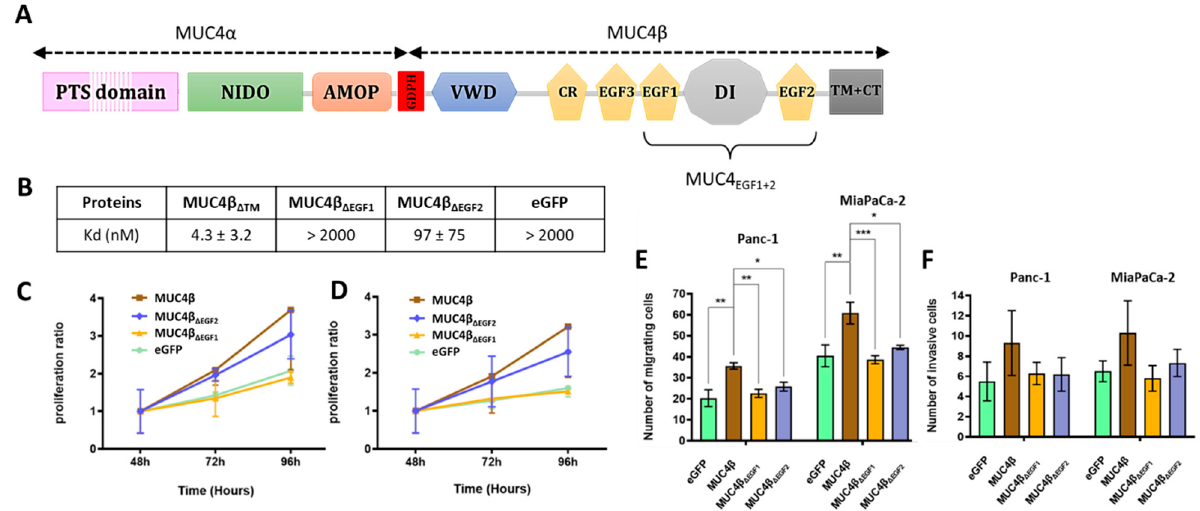
Figure 1. Impact of deletion of MUC4 EGF1 and MUC4 EGF2 domains on binding affinities with HER2 and on proliferation and migration properties of human PC cells. ( A ) Schematic representation of the membrane ‐ bound mucin MUC4 featuring both subunits MUC4 α and MUC4 β . MUC4 α is rich in proline/serine/threonine residues (PST domain), is strongly O ‐ glycosylated, and contains the AMOP and the NIDO domains. The subunits are post ‐ transcriptionally cleaved by an auto ‐ cleavable GDPH sequence and noncovalently associated. MUC4 β is formed by a von Willebrand factor ‐ D (VWD), an uncharacterized strongly N ‐ glycosylated part, a cysteine ‐ rich domain (CR), two EGF ‐ like domains (EGF3 and EGF1), an intermediate uncharacterized domain (DI), another EGF ‐ like domain (EGF2), and a transmembrane helix (TM) with a short cytoplasmic tail (CT). ( B ) Measurement of binding affinities between HER2 and eGFP ‐ MUC4 β Δ TM containing the EGF domains (MUC4 β Δ TM ) and the deleted forms for each EGF domain: eGFP ‐ MUC4 β Δ EGF1 (MUC4 Δ EGF1 ), eGFP ‐ MUC4 β Δ EGF2 (MUC4 Δ EGF2 ), or eGFP alone (mock, negative control), using MST. Measurement of Panc ‐ 1 ( C ) and MiaPaCa ‐ 2 ( D ) cell proliferation after transfection with eGFP ‐ MUC4 β containing the EGF domains and the deleted forms for each domain: MUC4 β Δ EGF1 , MUC4 β Δ EGF2 , or eGFP alone (negative control). Proliferation ratio over eGFP was calculated for each construct. Measurement of cell migration with Boyden chamber (control insert) ( E ) and cell invasion with Boyden chamber (Matrigel ® insert) ( F ) in Panc ‐ 1 and MiaPaCa ‐ 2 cells after transfection with eGFP ‐ MUC4 β , the deleted forms MUC4 β Δ EGF1 and MUC4 β Δ EGF2 , or eGFP alone (negative control). Statistically significant differences between eGFP ‐ MUC4 β and the deleted forms of MUC4 or eGFP alone are indicated; * p < 0.05, ** p < 0.01, and *** p < 0.001.